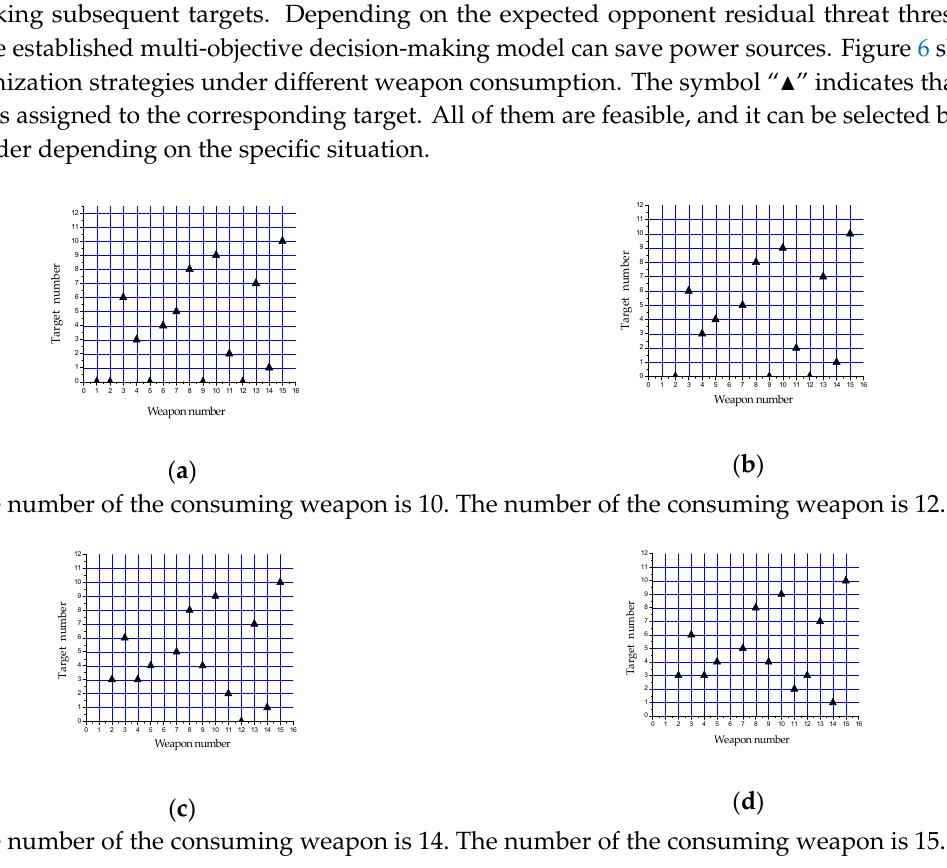
Figure 5. Distribution uniformity of Pareto optimal set of algorithms.